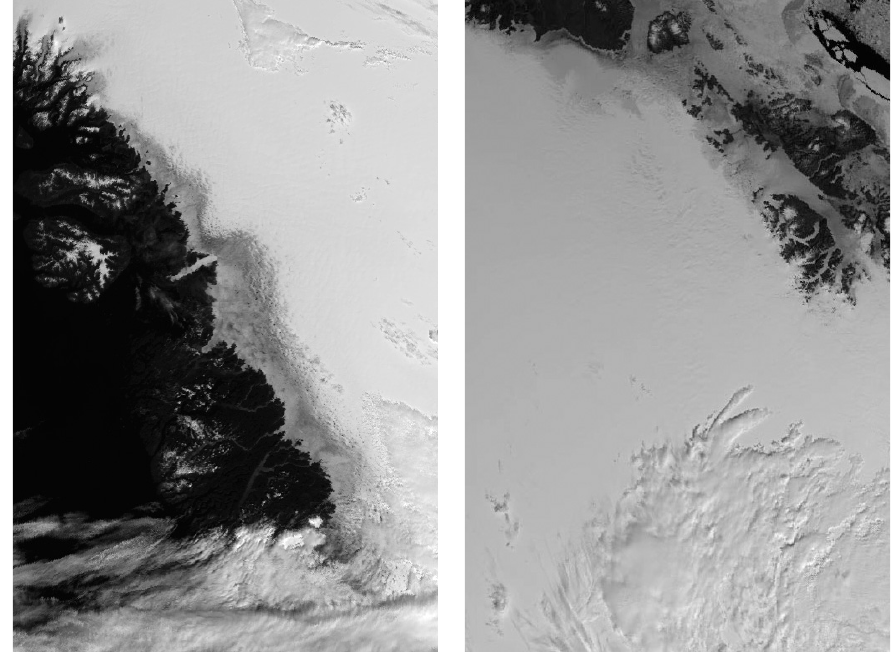
Fig. 14. AATSR nadir view reflectances at 550nm for the area near Kangerlussuaq (left panel) and for the NE-Greenland (right panel). Neither of them shows signs of aerosol